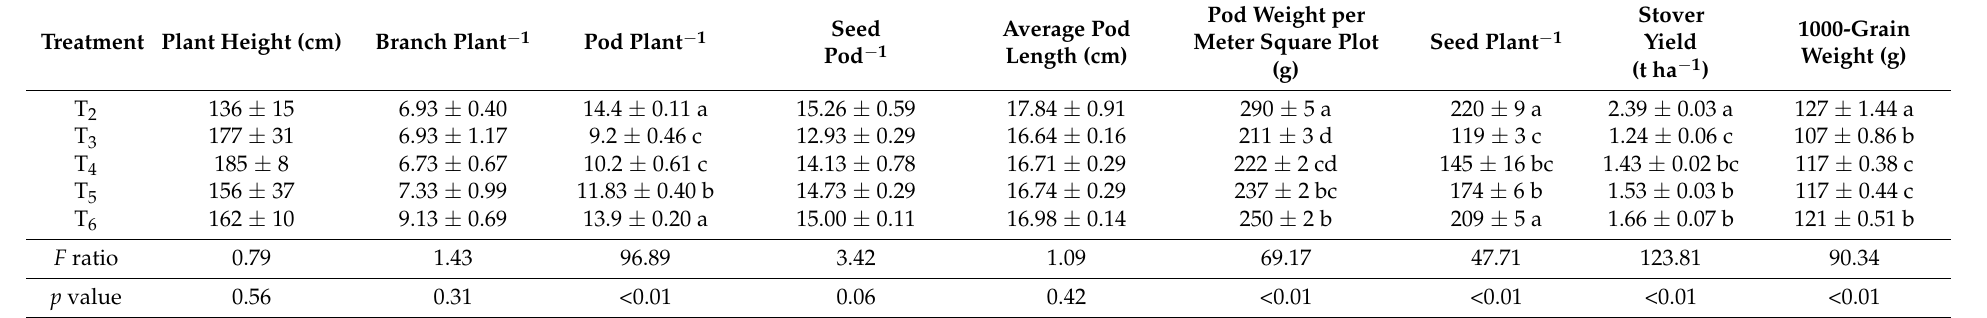
Table 3. Yield and yield-contributing characters of cowpea grown under different intercropping practices (means ± SE, N = 3).